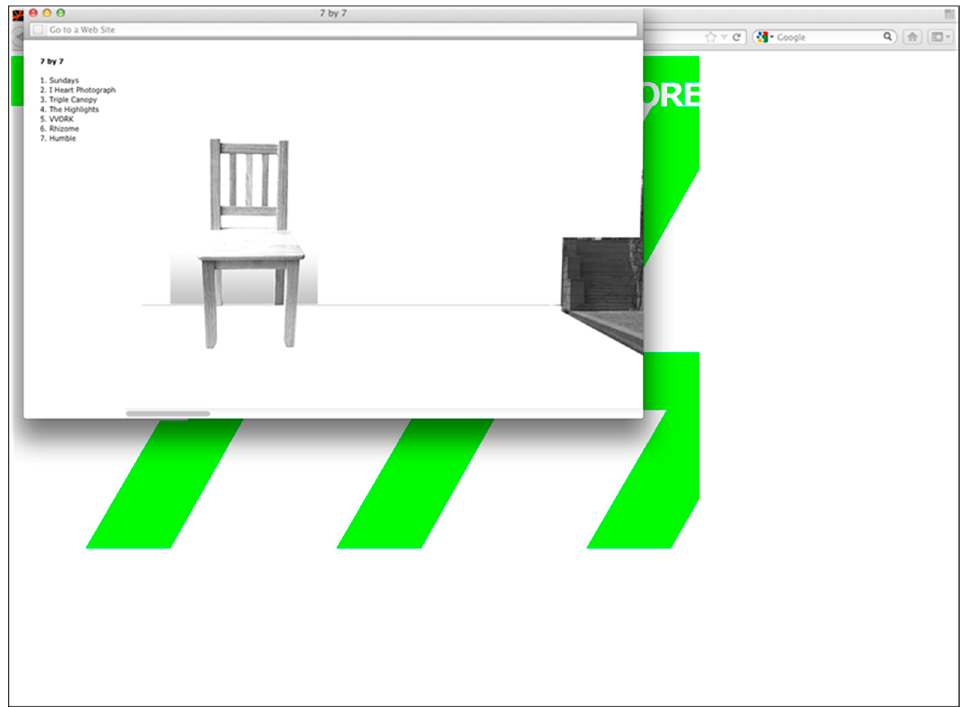
Figure 11. Why + Wherefore—7 by 7 exhibition, 2007. Screenshot of exhibition page, 2012. © Why + Wherefore, 2019.